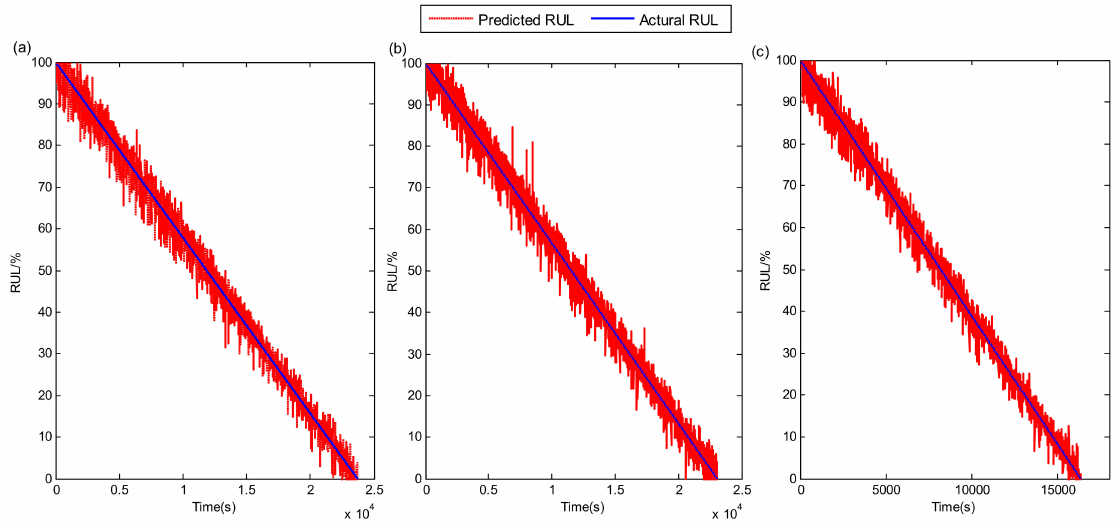
Figure 12. RUL prediction results of the PHM2012 dataset. ( a ) bearing1_3; ( b ) bearing2_5; ( c ) bearing3_2.